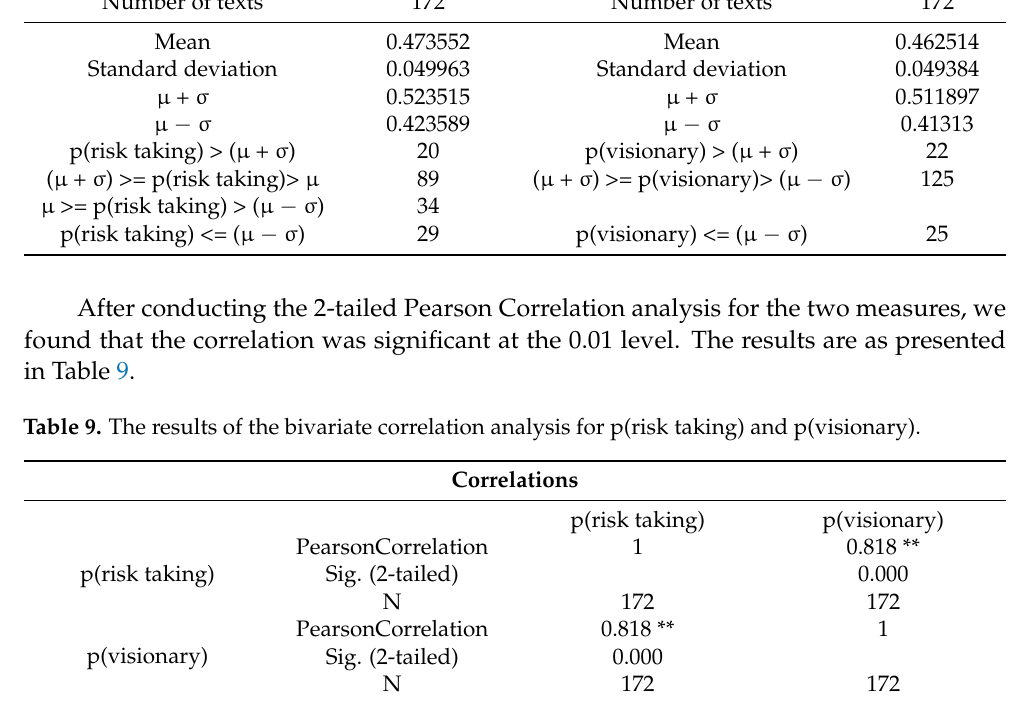
Table 8. The results of the proposed measures on a body of 172 texts for p(risk taking) and p(visionary). p(Risk Taking) p(Visionary) Number of texts 172 Number of texts 172 Mean 0.473552 Mean 0.462514 Standard deviation 0.049963 Standard deviation 0.049384 µ + σ 0.523515 µ + σ 0.511897 µ − σ 0.423589 µ − σ 0.41313 20